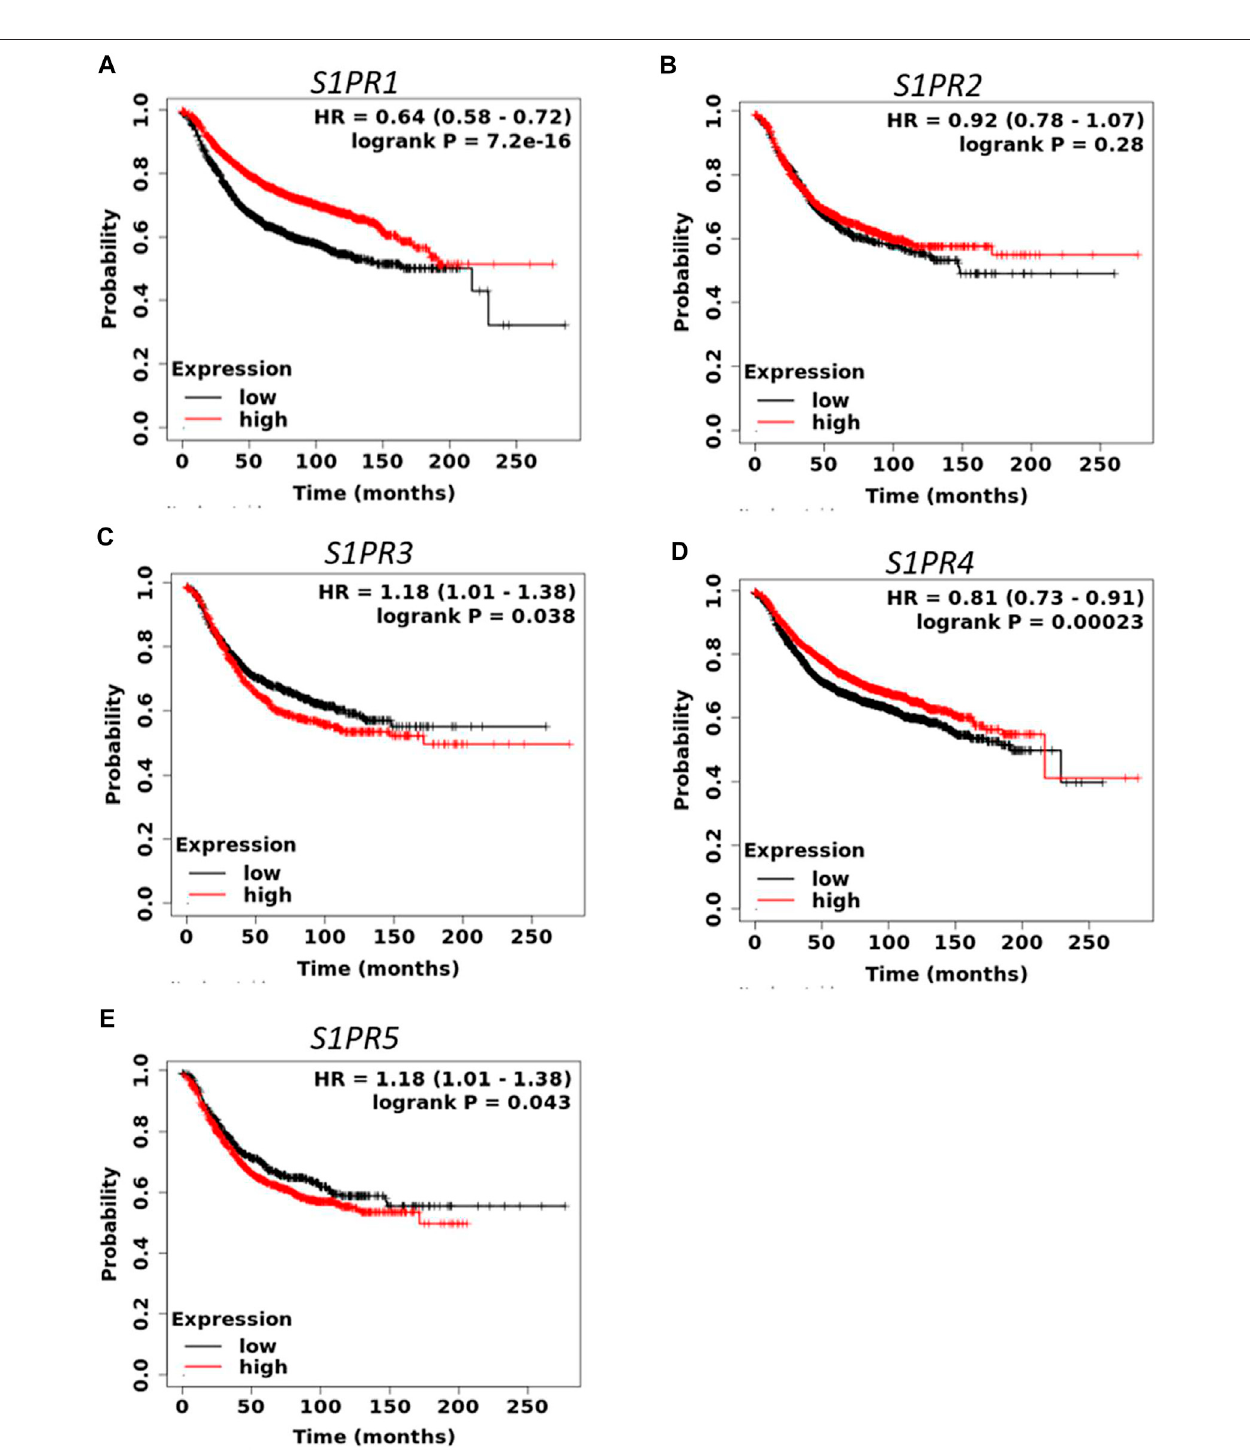
FIGURE 2 | Prognostic role of mRNA expression of S1P receptors (A – E) in breast cancer patients. Kaplan-Meier survival curves (RFS) were plotted for S1P receptors from the publicly available KM plotter database (N (cid:2) 3955 BC).